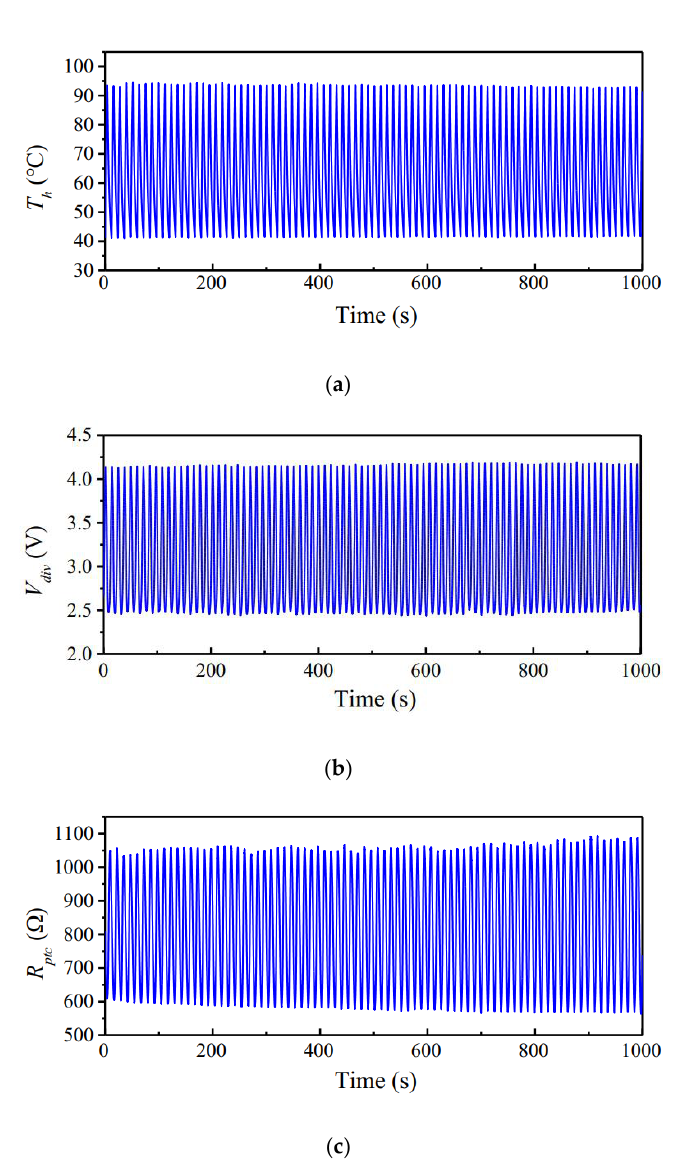
Figure 10. The results of long-term tests for a 1000 s subset of the 7200 s duration test. ( a ) Result of T h . ( b ) Result of V div . ( c ) Result of R PTC .